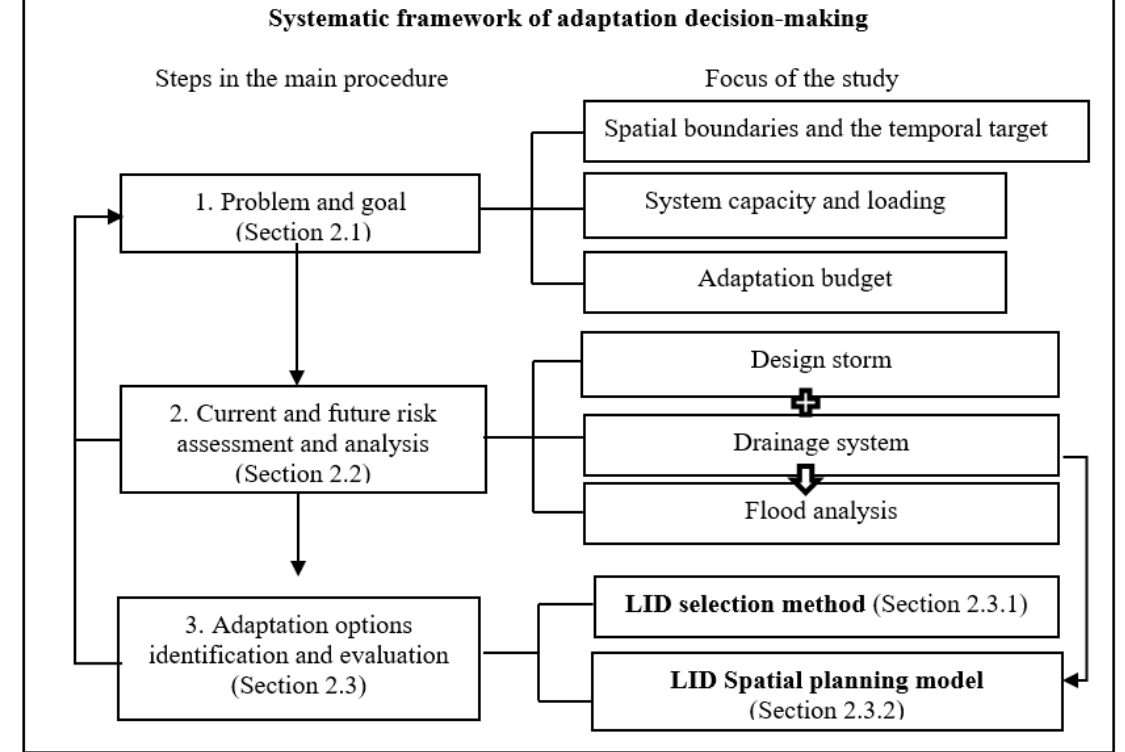
Figure 1. Systematic framework of adaptation decision-making.